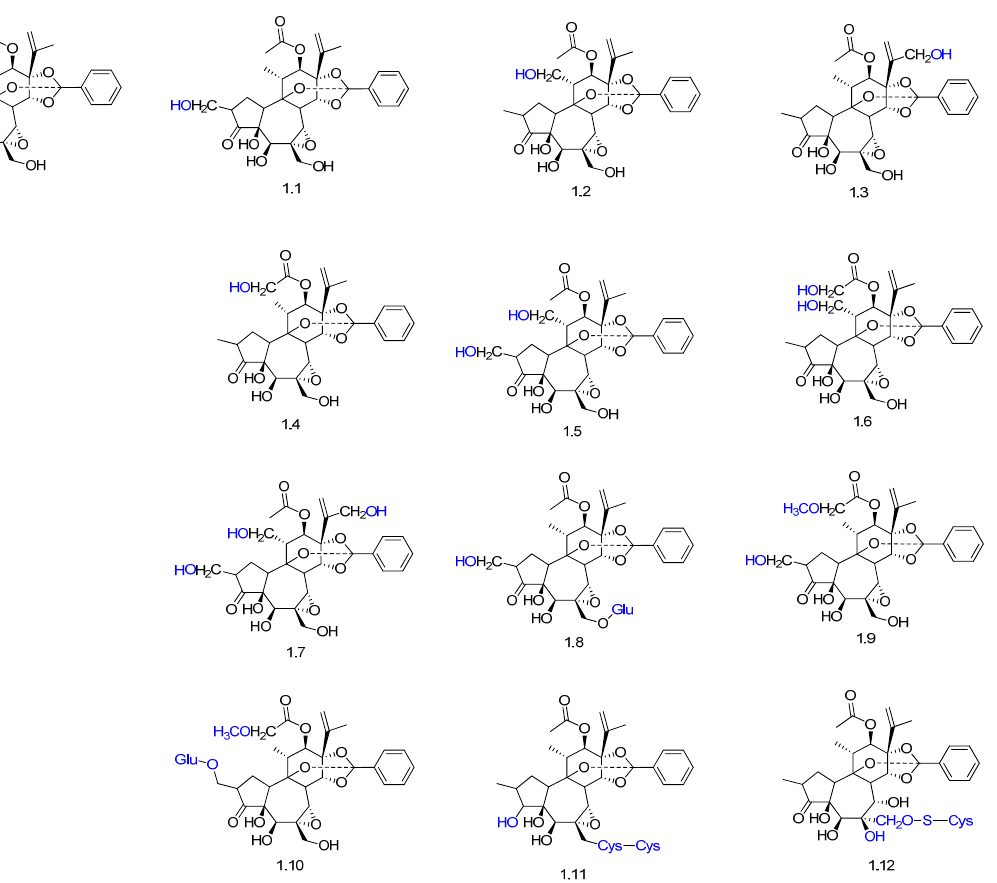
Figure 3. Proposed metabolites of yuanhuapine ( 1 ) detected in rat urine after oral administration [49].